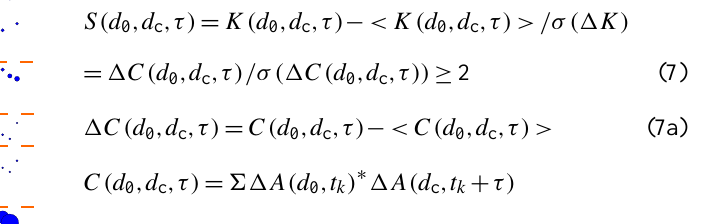
Fig.3а. Depth-time (d, t) diagram of the seismic variability indices for Bougainville zone. Bubble size is proportional to e ovals. Boundaries of the 5 layers are shown by dotted lines.